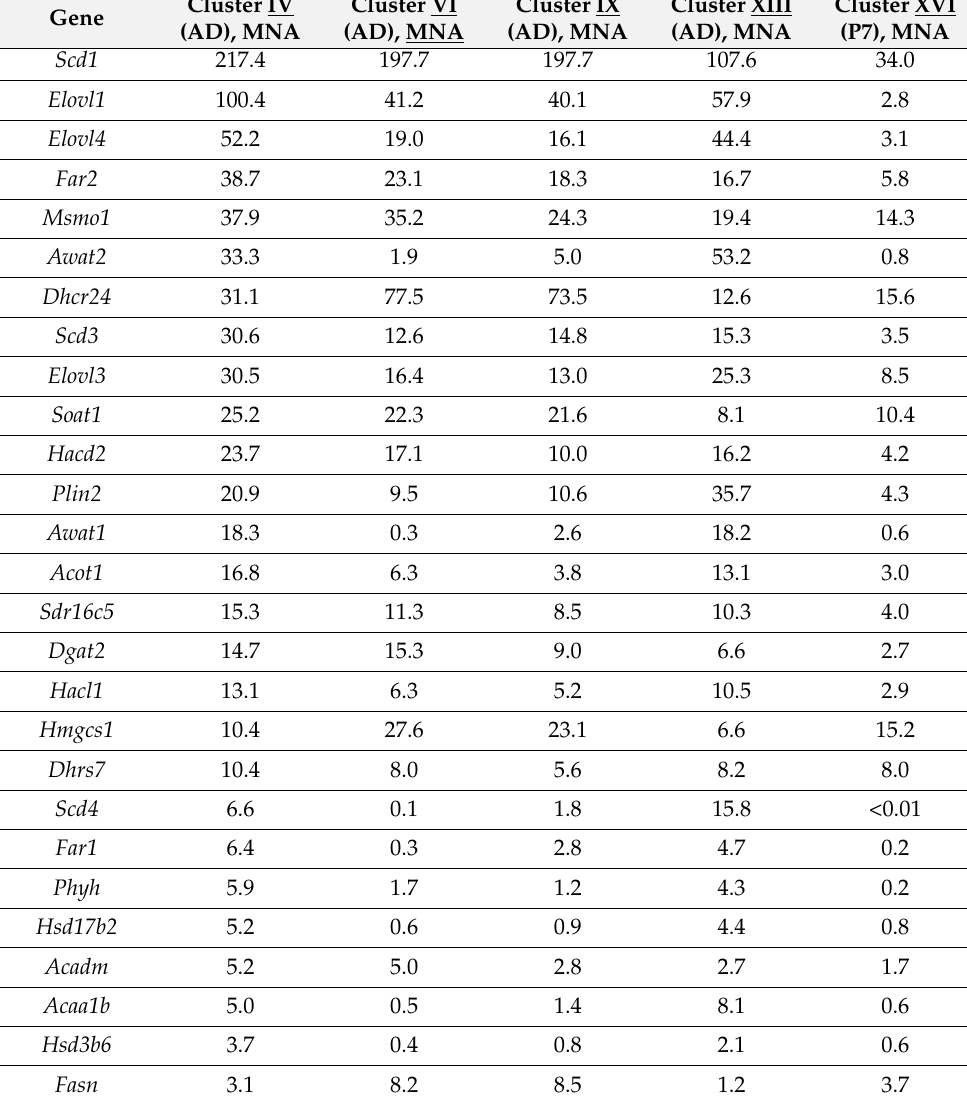
Table 1. Gene expression patterns in cell clusters of the AD and P7 mouse tarsi. The list of genes is based on the previously published data on the gene expression patterns in mouse and human Meibomian glands. The data are shown as Median Normalized Averages (MNAs) of genes in the clusters calculated in Loupe Browser as the means of observed UMI counts normalized by the size factor for each cell in the respective